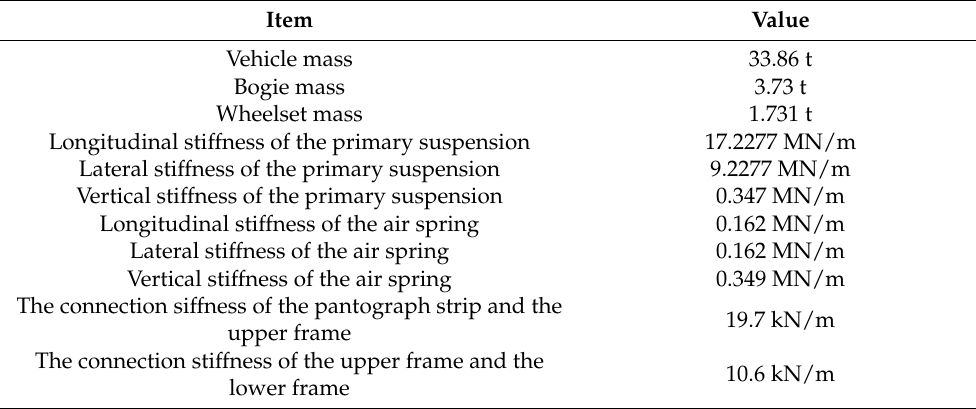
Figure 5. Nonlinear characteristics of the vehicle suspension system. ( a ) Nonlinear characteristics of the primary vertical dampers; ( b ) Nonlinear characteristics of the secondary lateral bumpstop foce. Table 1. Model parameters of the type B metro vehicle operating on Z City Metro Line 1.